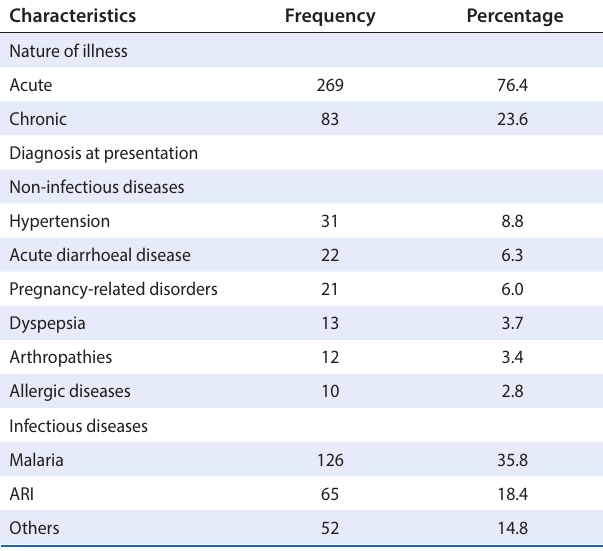
Table 4: Illness characteristics of subjects Characteristics